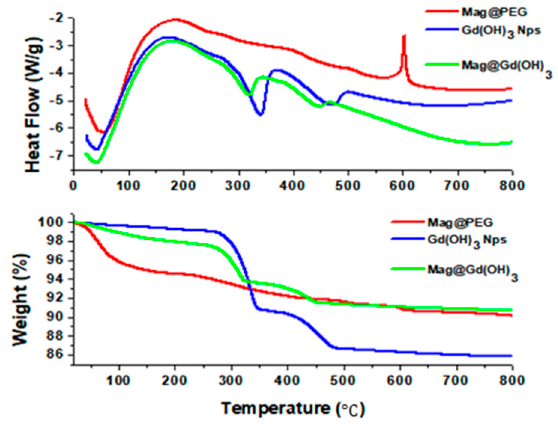
Figure 7. DSC (top) and TG (bottom) curves of the raw and hybrid nanoparticles. Figure 7. DSC ( top ) and TG ( bottom ) curves of the raw and hybrid nanoparticles. The DSC/TG curves of Gd(OH) 3 Nps show a gradual weight loss between room temperature and 230 ◦ C, which corresponds to surface water desorption.